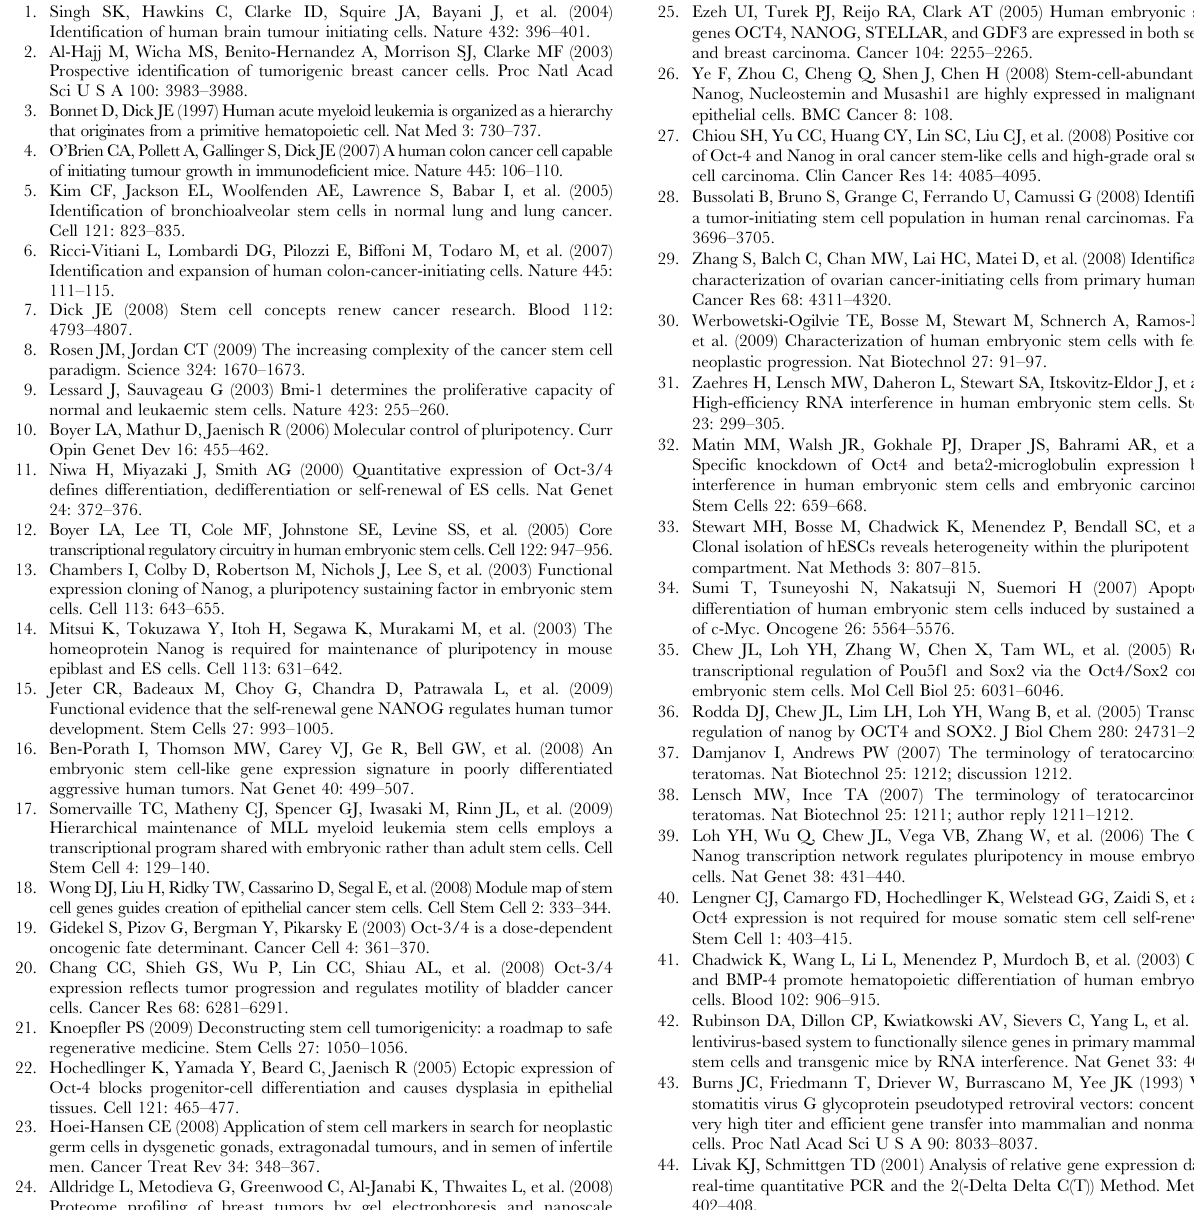
hPSCs respectively. Sorted cells were seeded at clonal density on irradiated hdFs and sorting purities for each fraction are shown.